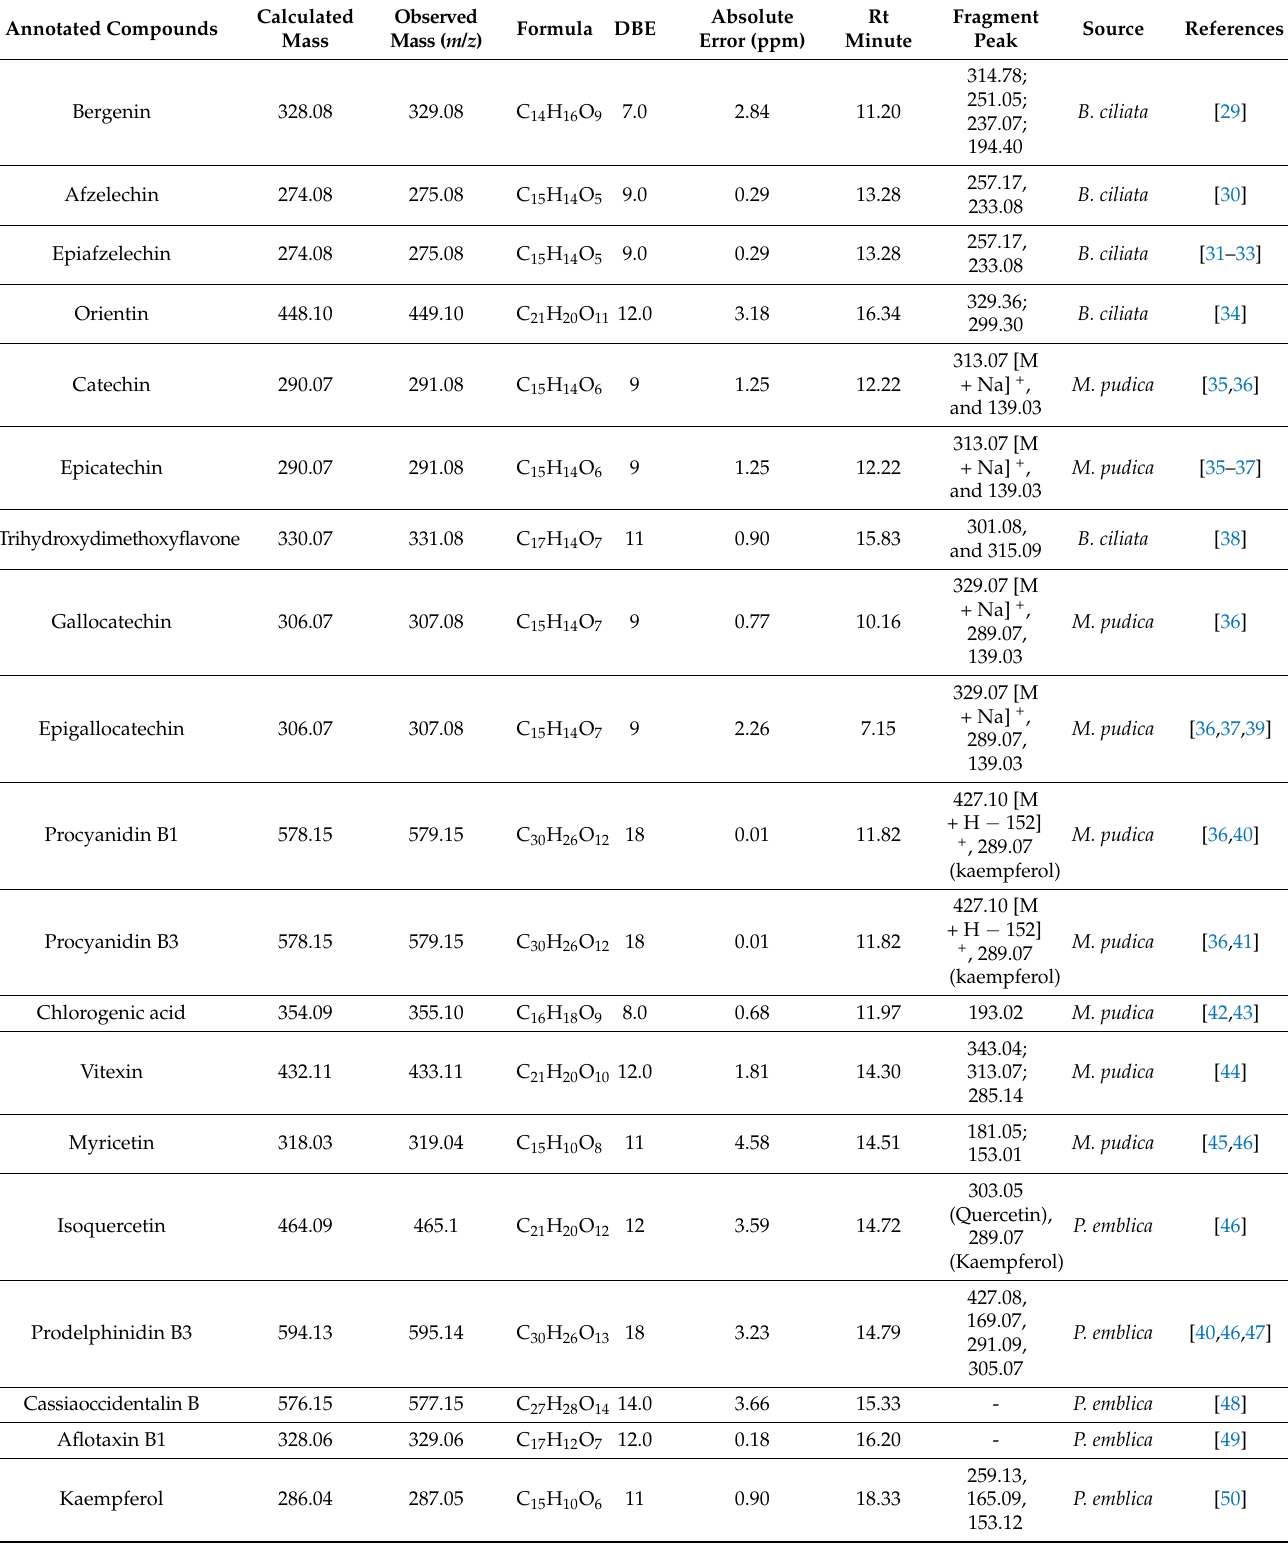
Table 5. Secondary metabolites identified from B. ciliata , M. pudica , and P. emblica through mass